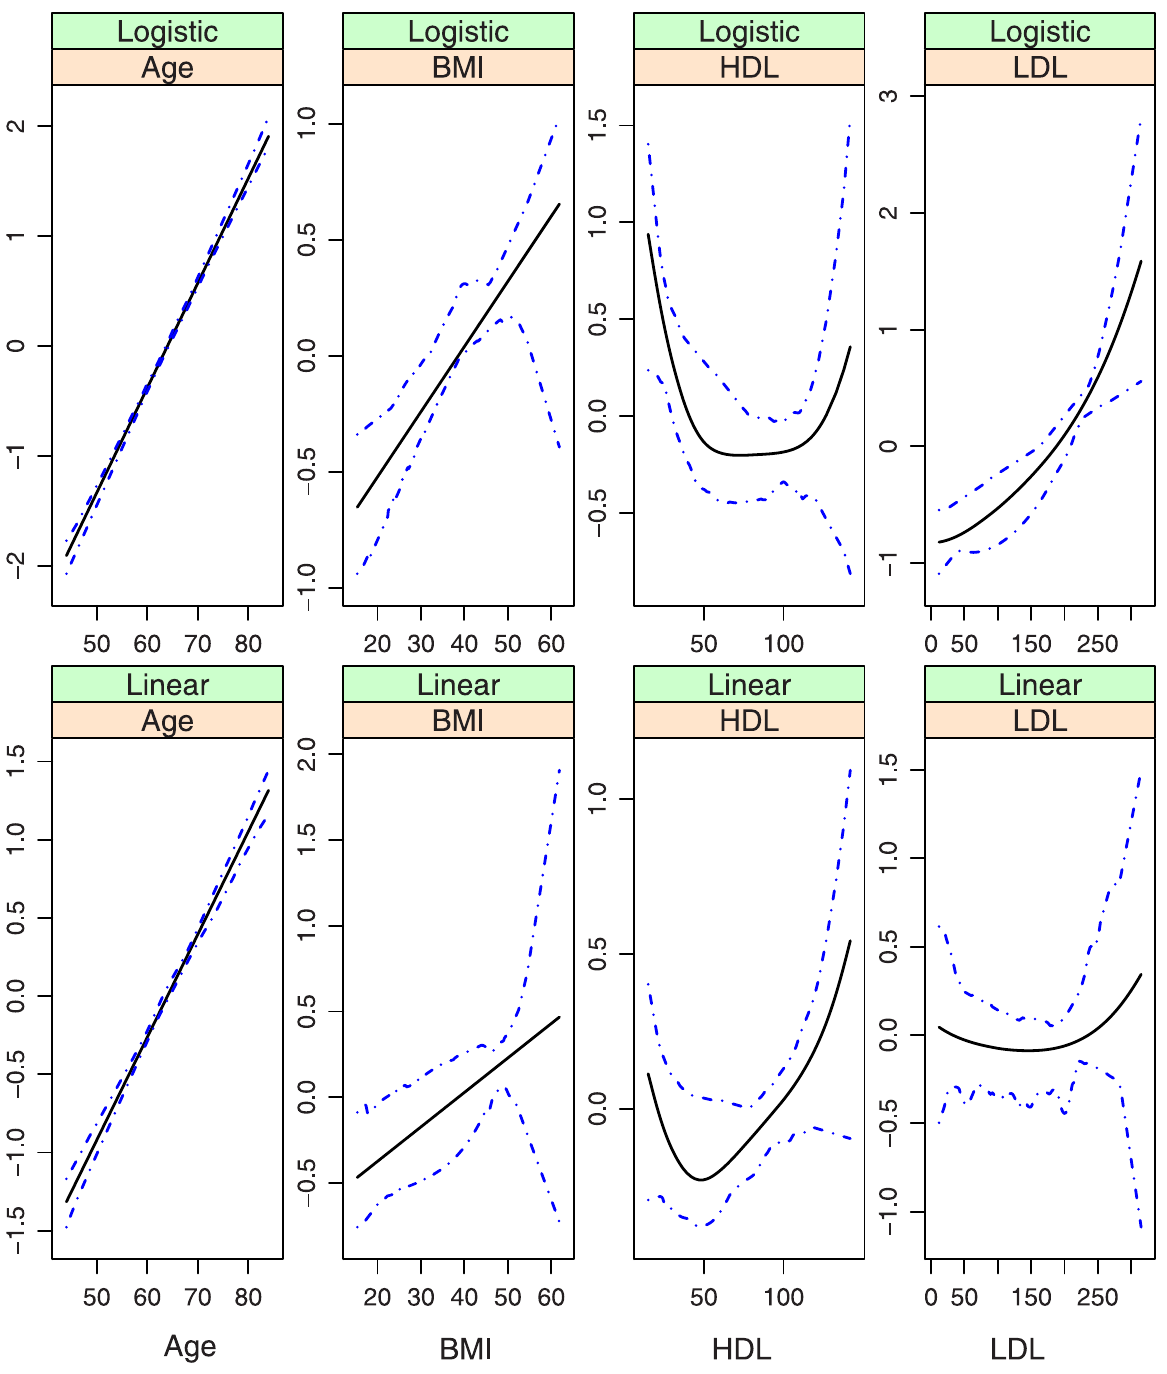
Figure 7. Model (iv): estimated covariate effects for age, BMI, HDL, and LDL. The solid line is the estimate. The dash-dotted lines are the point-wise 95% confidence intervals. The y-axis is the value of the function.